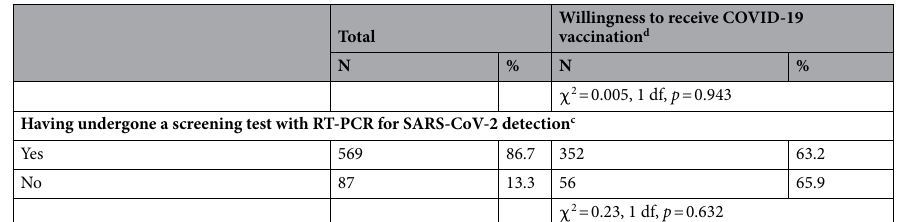
Table 1. Selected socio-demographic and anamnestic characteristics and the associated willingness to receive COVID-19 vaccination (N = 865). a Mean ± standard deviation (range). b Fever, cough, difficulty breathing, cold, sudden loss or decrease of smell, loss or alteration of taste, diarrhea, sore throat. c Number for each item may not add up to total number of study population due to missing values. d The frequency values of the respondents regarding the willingness to receive COVID-19 vaccination do not refer to the total number of the selected population due to the missing values.